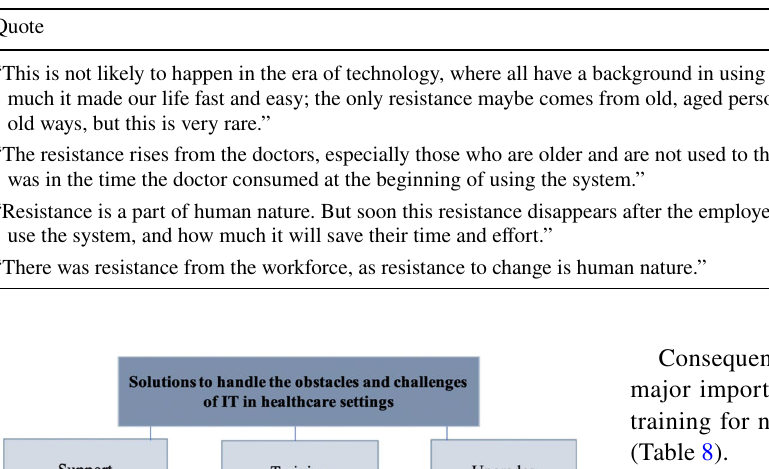
Table 6 Barriers to IT implementation in healthcare settings due to human factors